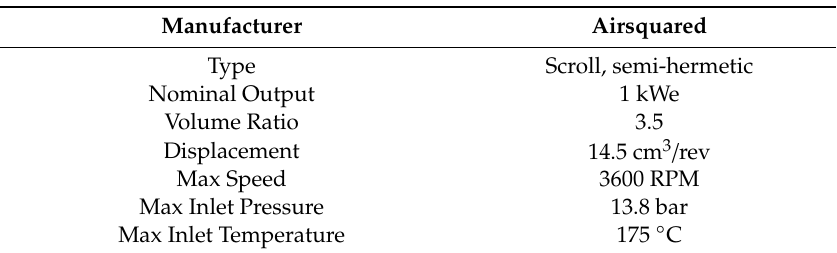
Table 1. Details of the chosen expander